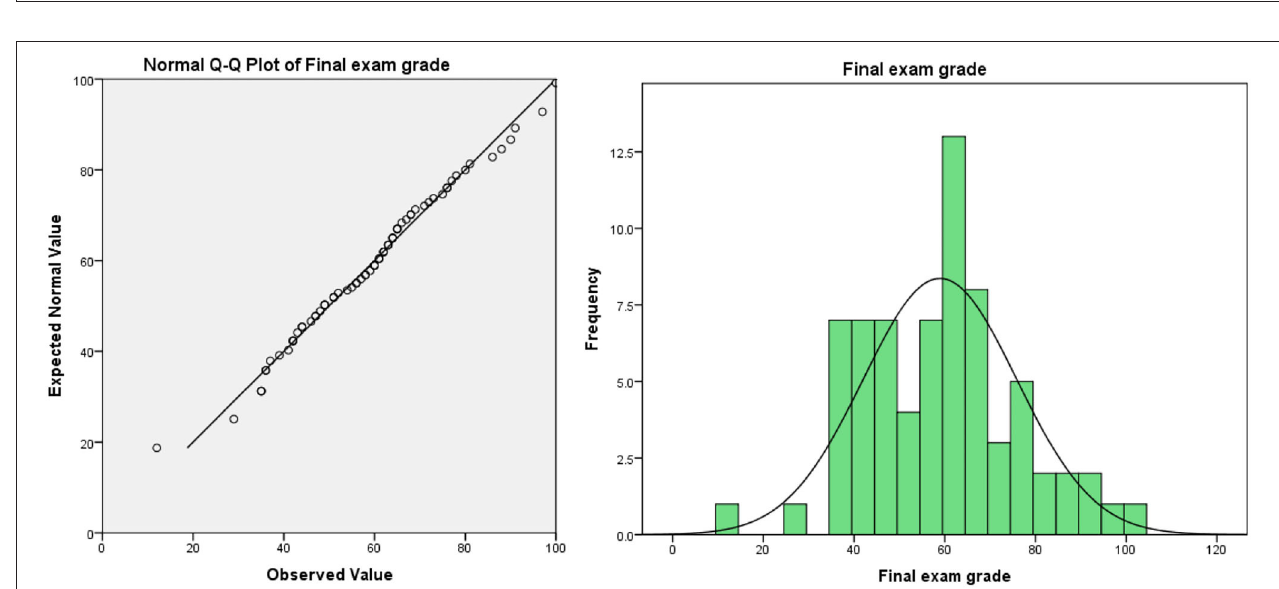
FIGURE 1 | Usual performance of teacher-oriented graduates majoring in bio-pharmaceutical.